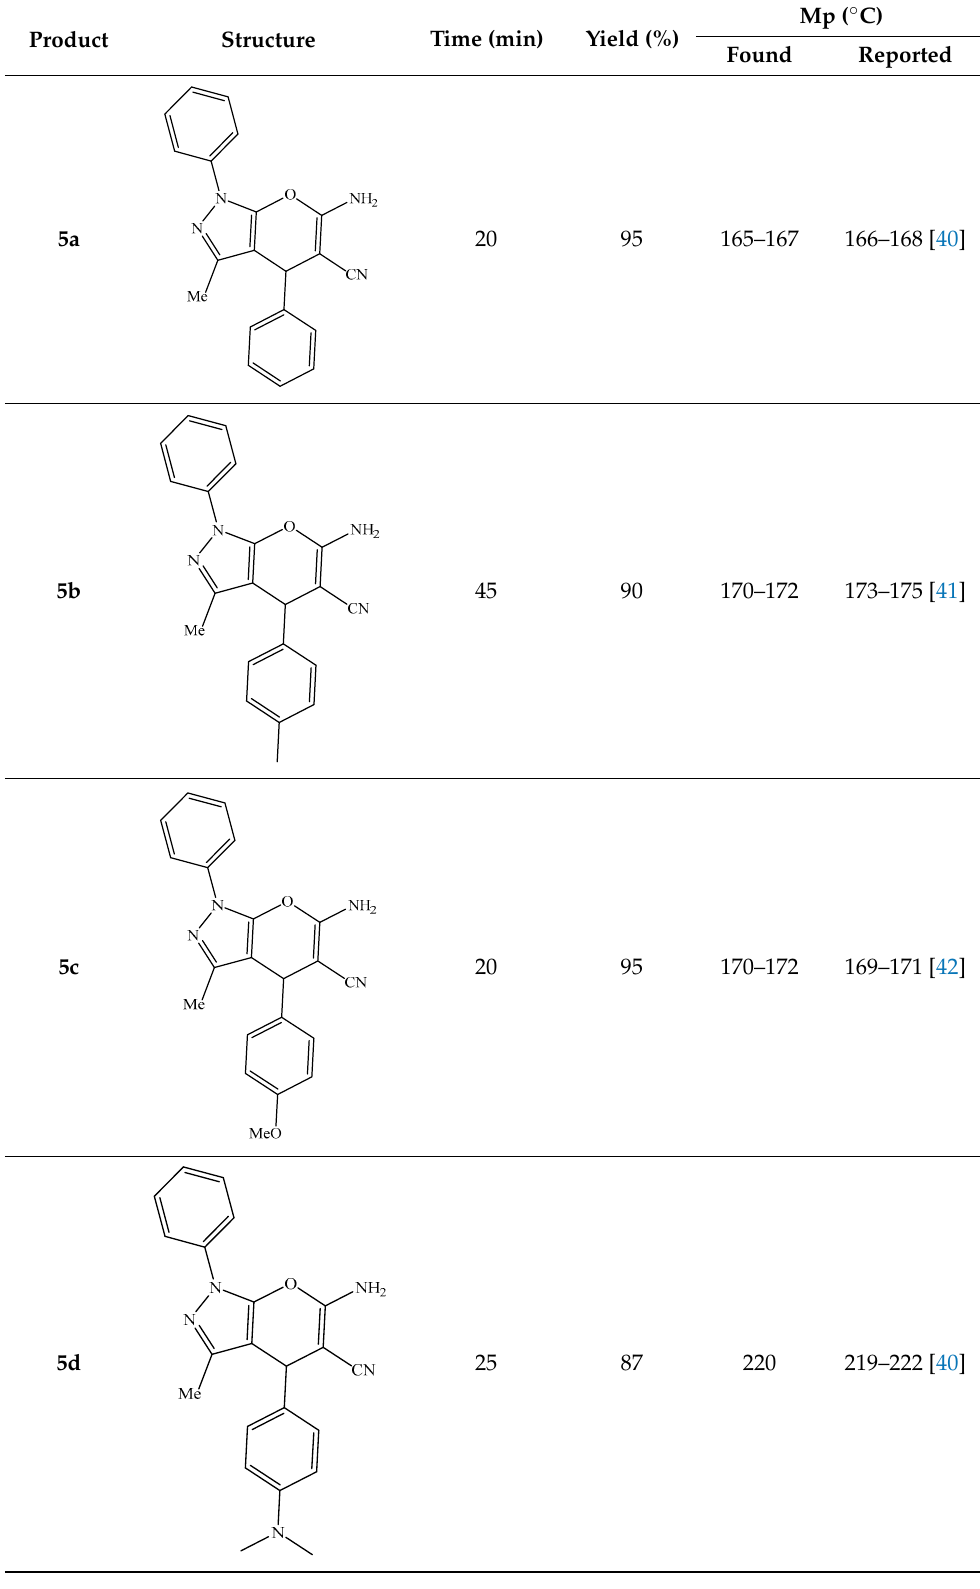
Table 2. 1,4-dihydropyrano[2,3-c]pyrazole-5-carbonitrile derivatives synthesized using zirconium magnetic nanocomposite as a catalyst. Product